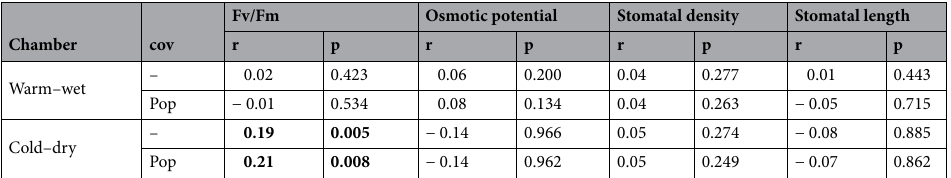
Table 2. Correlation between genetic relatedness of the genotypes and their similarity in response of each trait to 5-azaC application for each growth chamber separately. All the tests were done without a covariate (cov.) as well as with population of origin as a covariate. Significant values (p ≤ 0.05) are shown in bold.